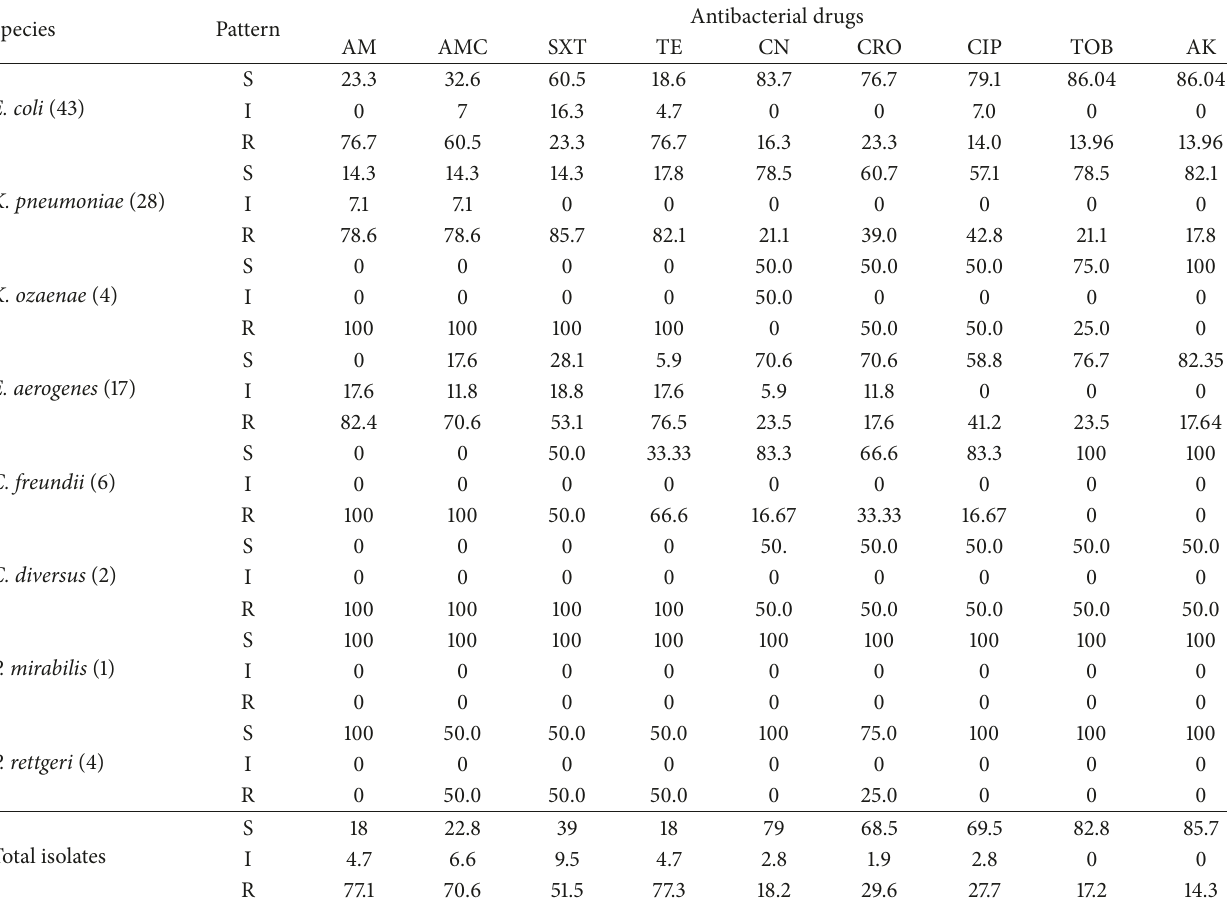
Table 4: Percentage of in vitro antibacterial susceptibility pattern of Gram-negative bacteria isolates ( 𝑛 = 105 ).